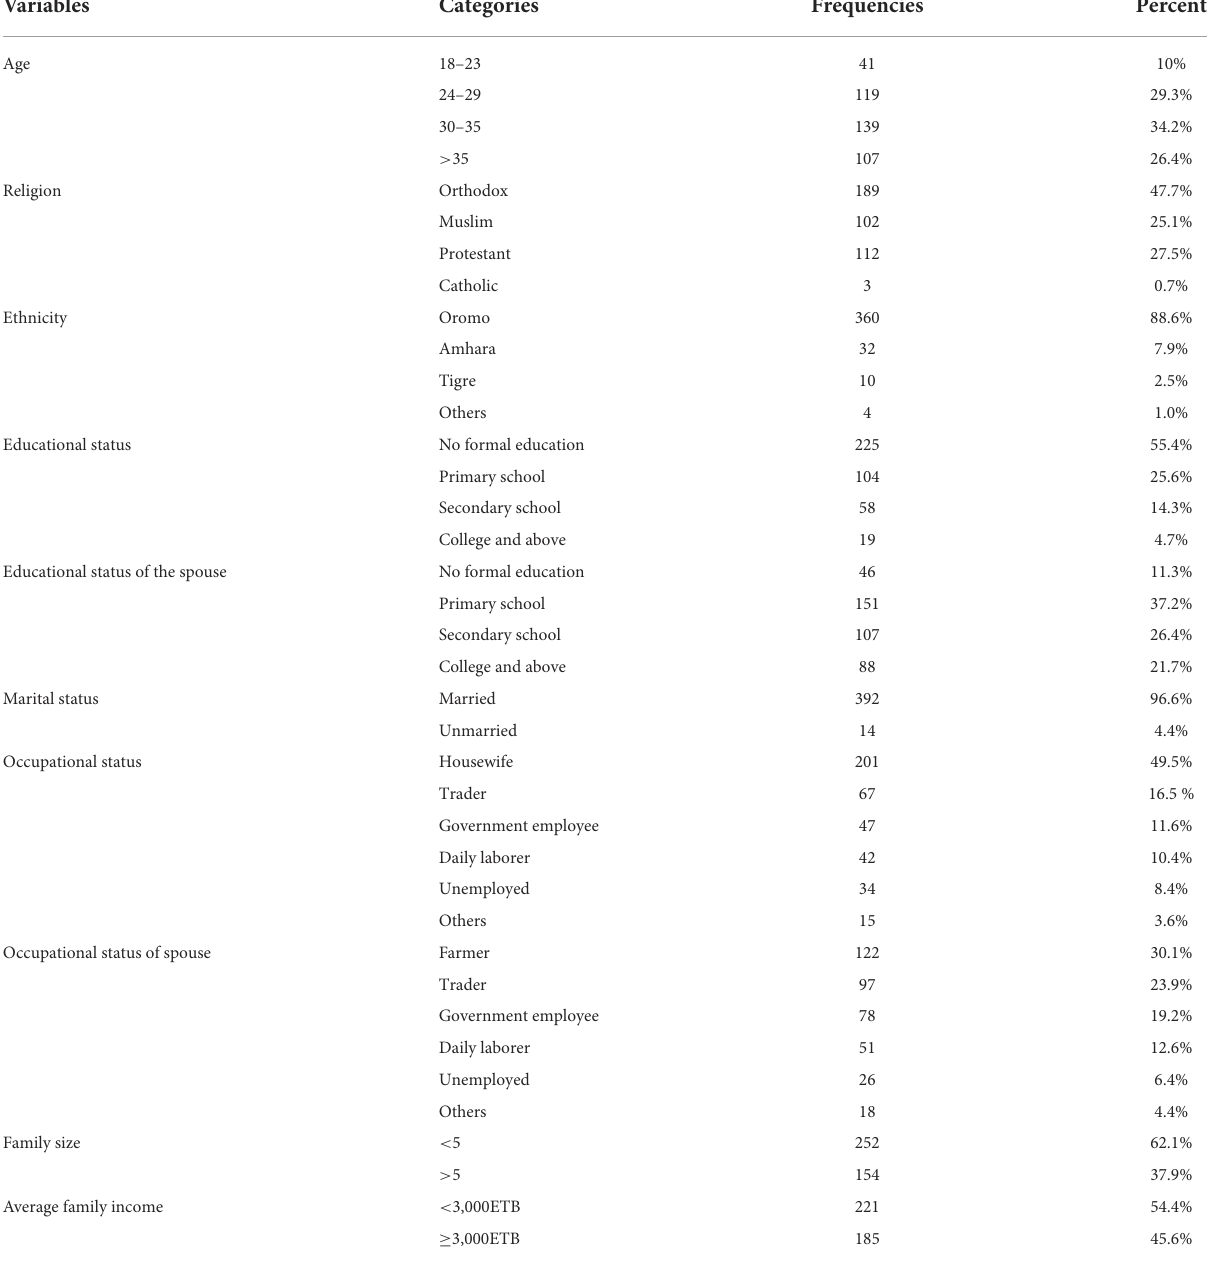
TABLE 1 Socio-demographic characteristics of pregnant women attending ANC follow-up at Bedelle general hospital and Metu Karl comprehensive specialized hospital, 2021 ( N = 406). Variables